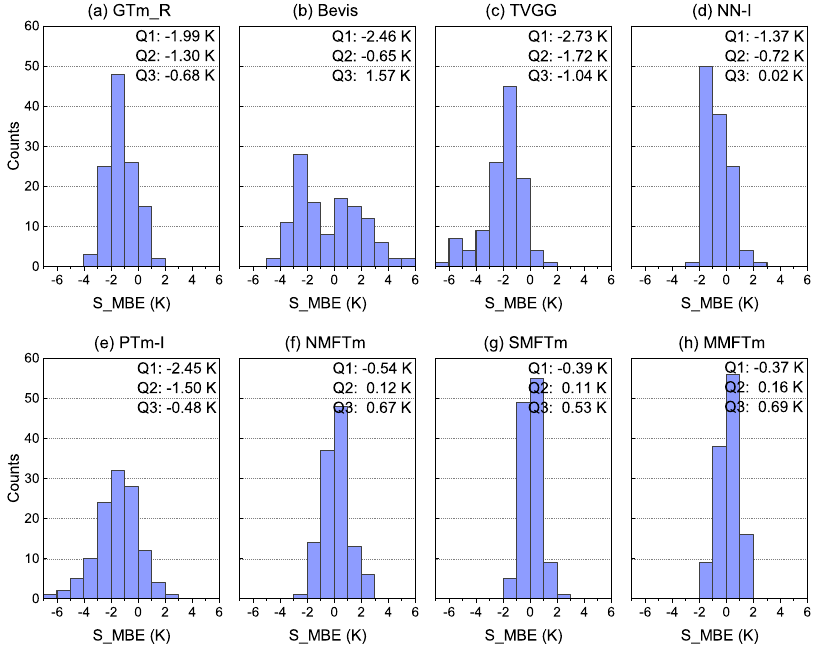
Figure 11. Histograms of S_MBE for different models tested by radiosonde data from 2016 to 2018 ( a – h